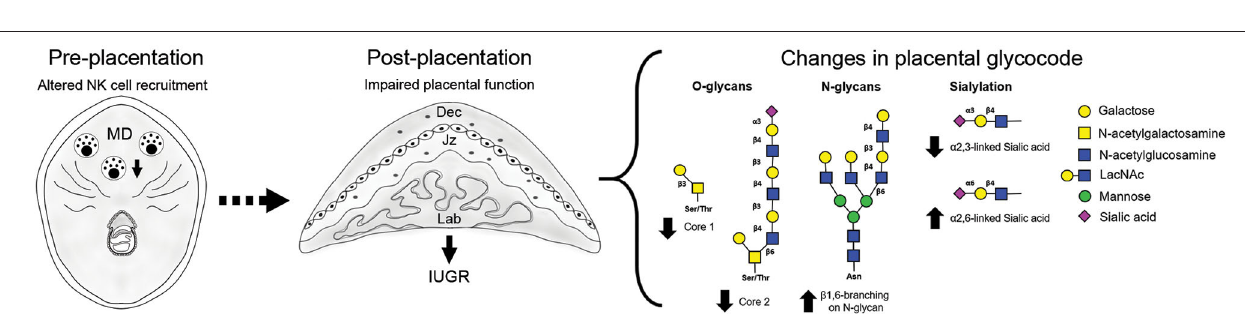
FIGURE 3 | Overview of the placenta glycocode dynamics in poor pregnancy outcome caused by disrupted NK cell recruitment. Fetal growth restriction as a consequence of NK cell depletion is associated with changes in O-glycan expression ( ↓ core 1 and core 2) in giant cells (GC). Junctional zone is characterized by increased expression of branched N-glycans and changes in sialylation ( ↓ α 2, 3- and ↑ α 2, 6- linked sialic acid). Placentas derived from NK ablated dams are characterized by an increased gal-1 expression.